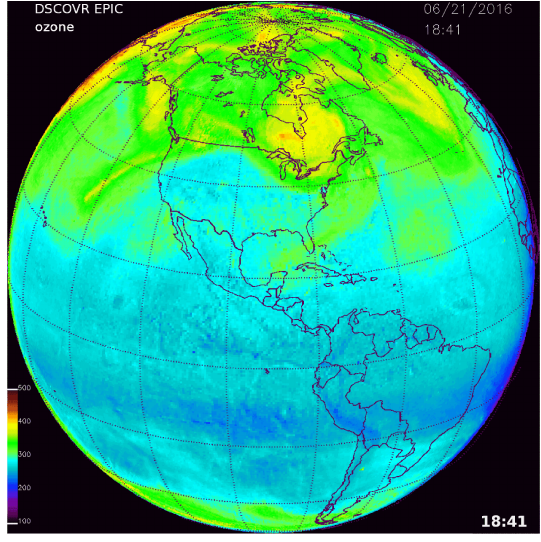
Figure 12. Global image of ozone field for Fig. 13 for 21 June 2016 at 18:41